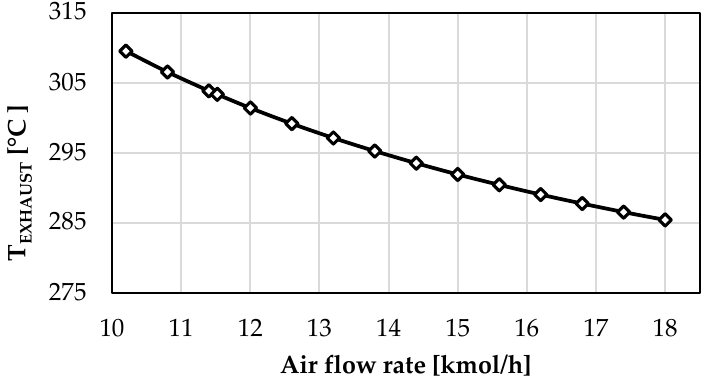
Figure 2. Exhaust temperature variation as a function of the airflow rate.